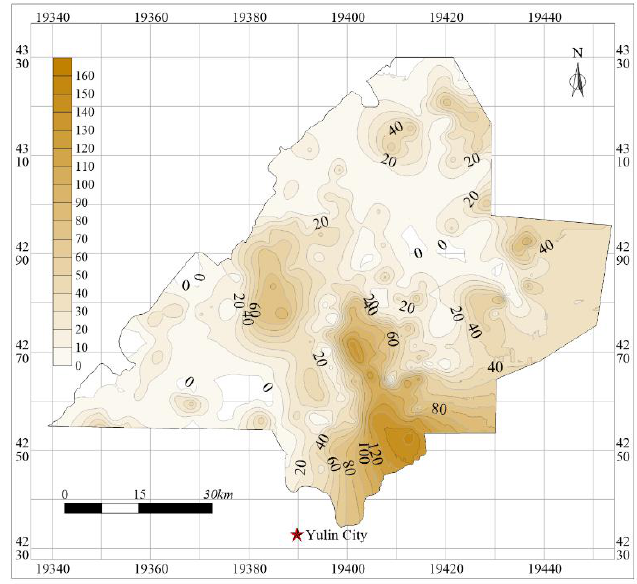
Figure 7. Aquiclude thickness contour map (Xi'an geodetic coordinate system 1980; in